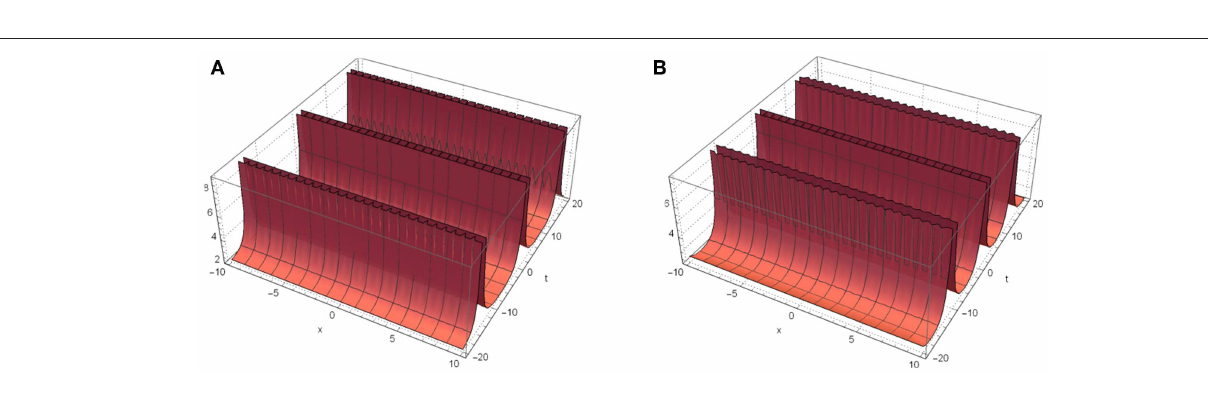
2 √ 21 k 2 = − 63 √ k 3 k 4